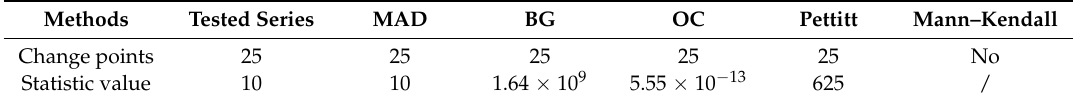
Table 2. Detection results of single mutation point series without